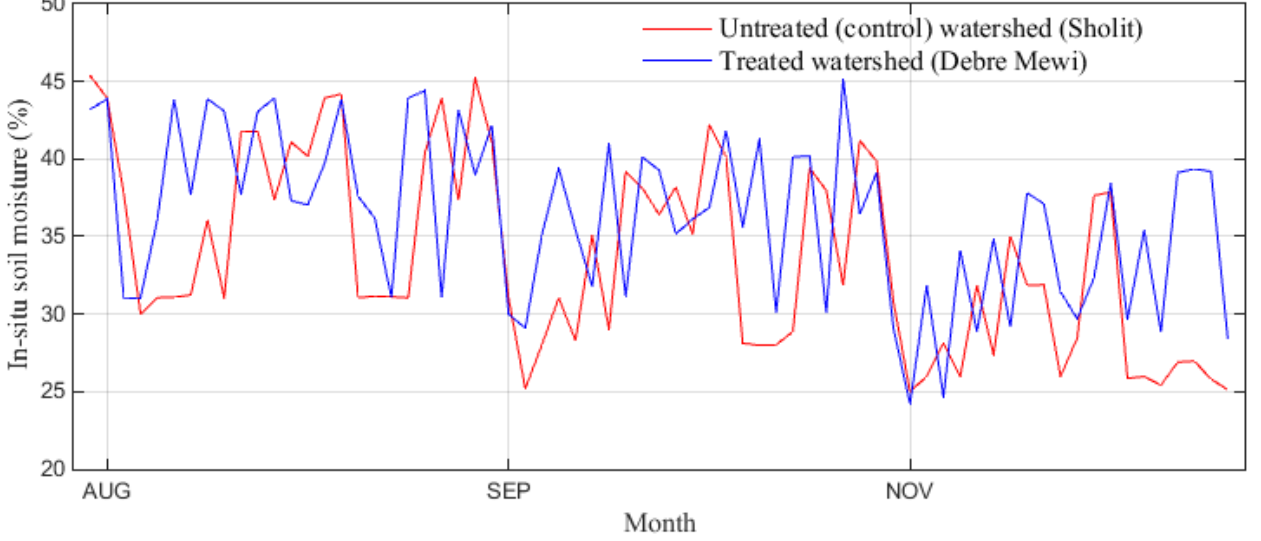
Figure 7. Soil moisture variation during the cropping season: August–November 2020.